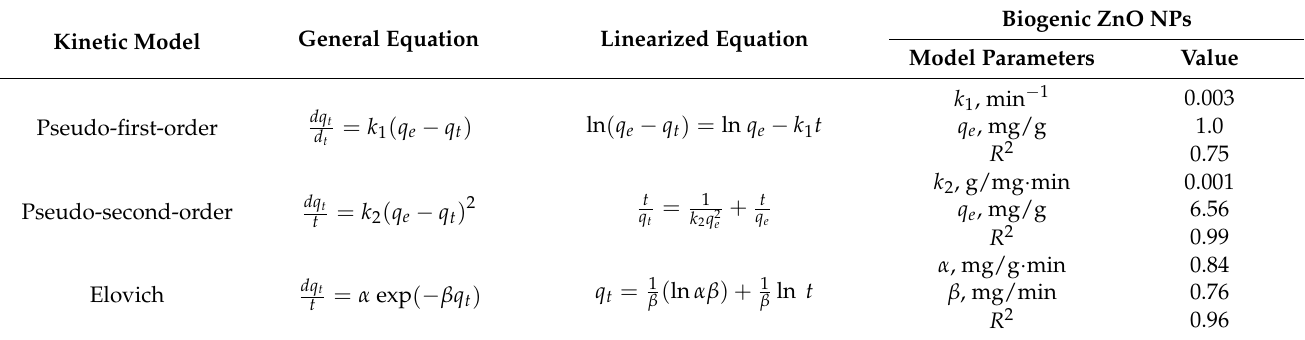
Table 3. Parameters calculated from various kinetic models (initial AY concentration: 20 mg/L, adsorbent dose: 50 mg, pH: